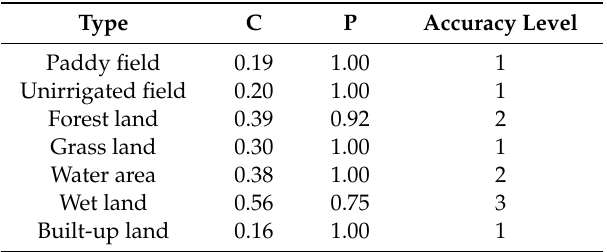
Table 8. Posterior di ff erence ratio (C), small error possibility (P) and rediction accuracy level of land use